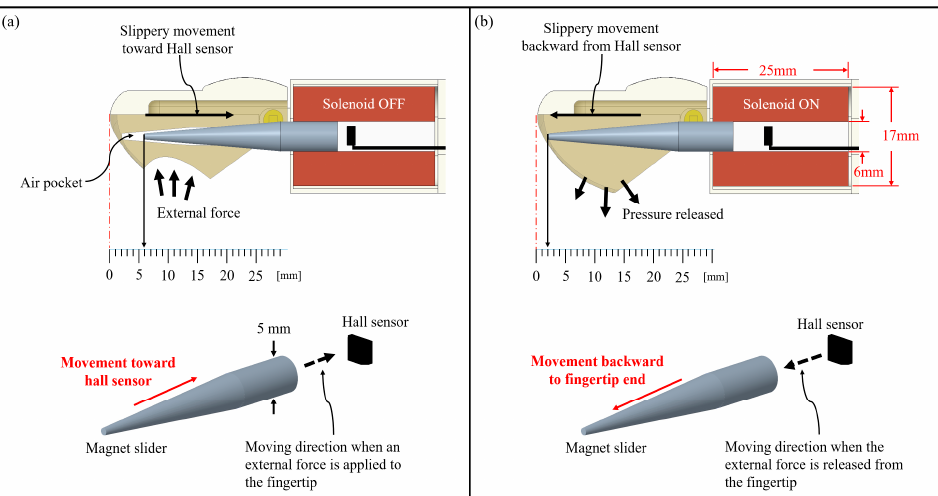
Figure 3. Sensing mechanism of the proposed fingertip pressure sensor based on the Hall effect, where the solenoid has a 6 mm inner and an approximately 17 mm outer diameter with a wire diameter of 0.25 mm. The solenoid is wound 1600 turns per cm. ( a ) When an external force is applied to the fingertip surface, which is a portion of the silicone elastomer, the magnet slider moves toward the Hall sensor, and an air pocket is left behind. ( b ) When the pressure is released, the magnet slider moves away from the Hall sensor.